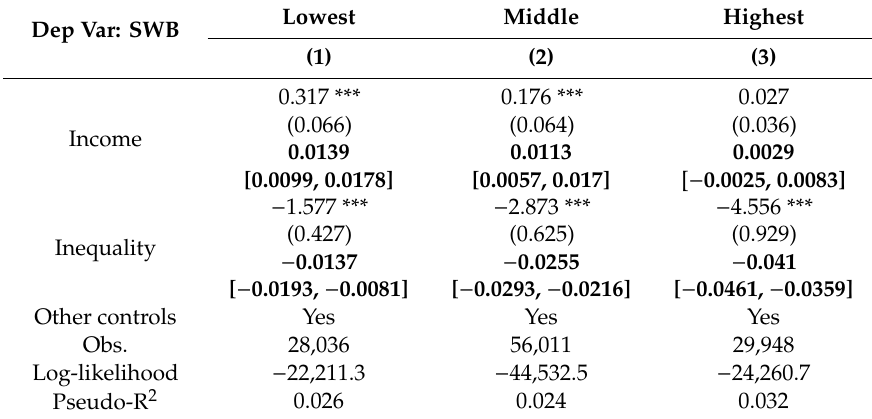
Table 5. Heterogeneous e ff ects by income quartiles. Lowest Middle Dep Var: SWB